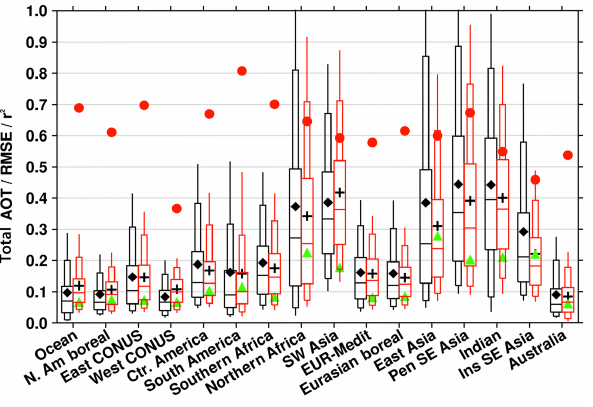
Figure 12. Same as Fig. 10, except for total AOT at 550nm. Also, AOT value greater than 1.0 is cropped in this